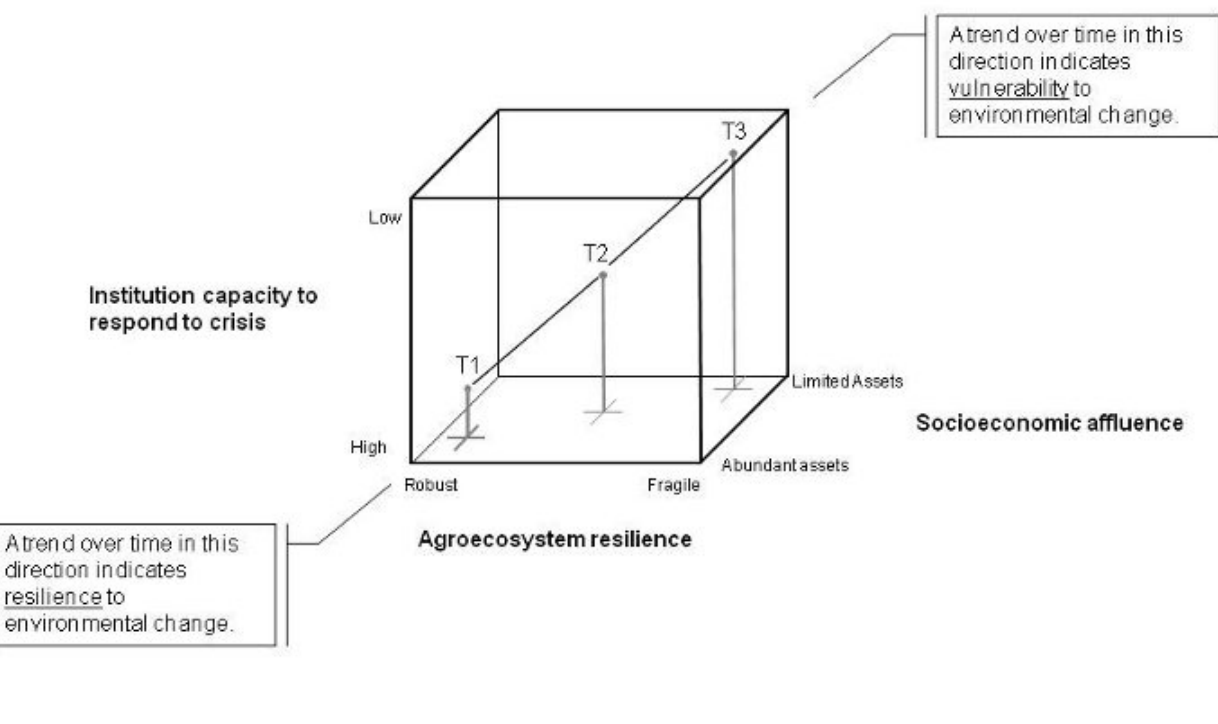
Fig. 1. Vulnerability space build-up along three “meta” categories: (1) sensitivity of agroecosystems to water stress, (2) access to capital assets, and (3) institutional capacity to adapt to